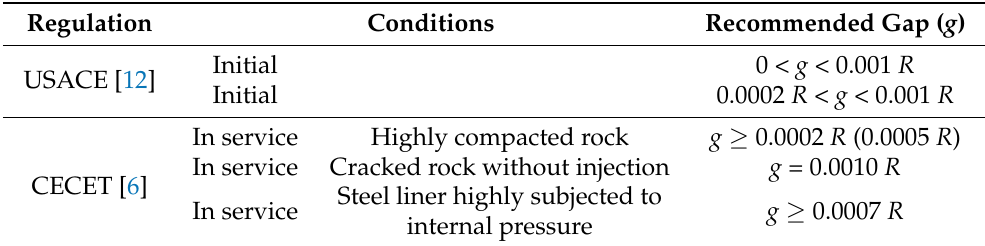
Table 4. Recommended values of the gap g between the liner and the encasing